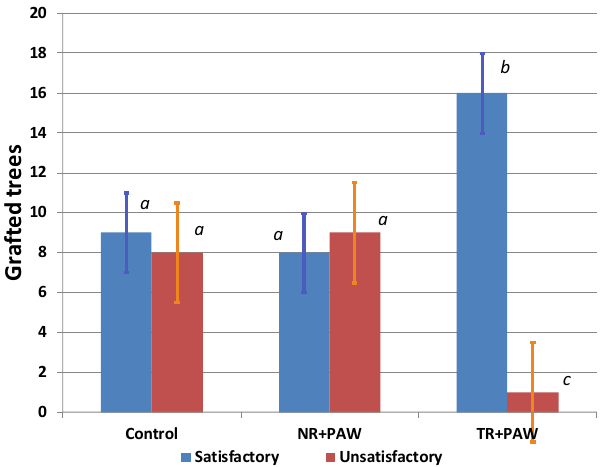
Figure 3. Effect of PAW and rootstock thickness on completed tree development and quality cate- gories. The “satisfactory” category included the trees with “good” and “average” development; the “unsatisfactory” category included “weakly” developed trees and the dead scions (see Table 6). The values significantly differing, according to the Fisher’s LSD criterion (see Section 3), are marked with different letters. Table 6. Effect of PAW and rootstock thickness on completed tree’s annual shoot growth, cm.